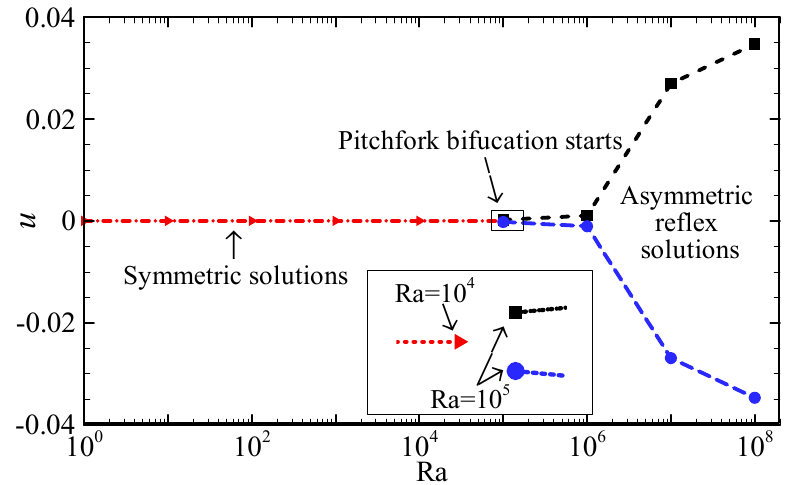
Figure 7. Pitchfork bifurcation in the Ra- u plane where u is the x -velocity at the point P 3 (0, 0.8).